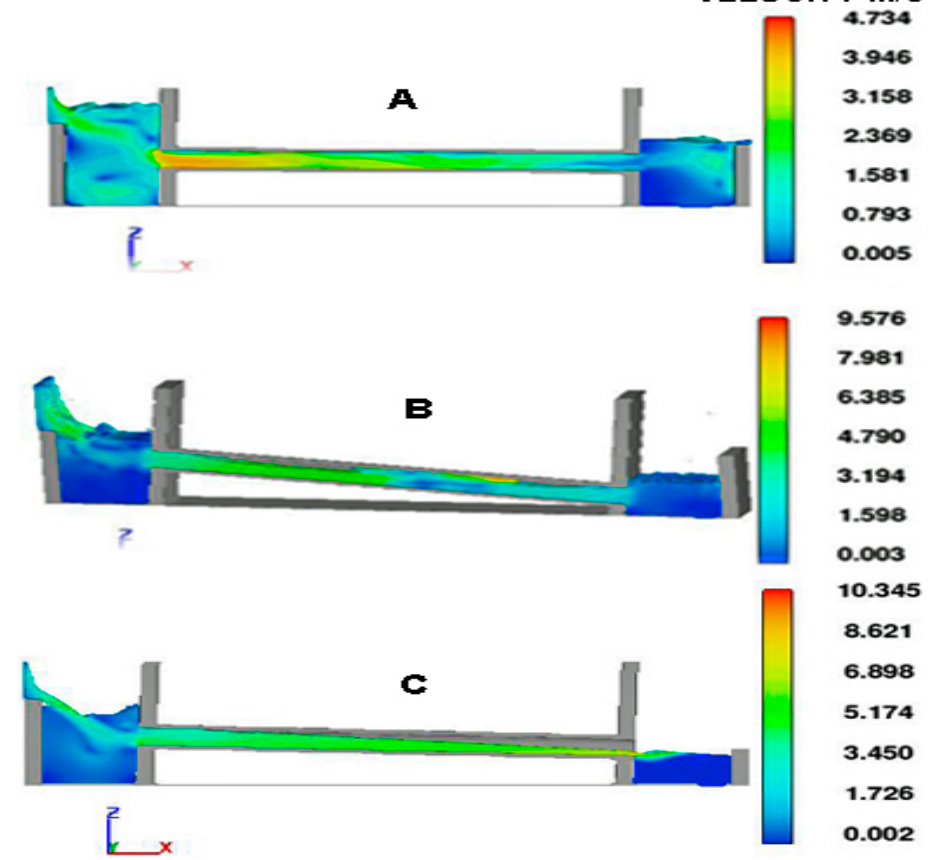
Figure 16. FLOW-3D computational fluid dynamics (CFD) results for Cases A – C . The hydraulic jump shown(directly under B ) in Case B causes pressure oscillations, inducing separation forces at pipeline connection joints amplifying the potential for joint leakage and does not support the highest flow rate possible despite its steeper slope.